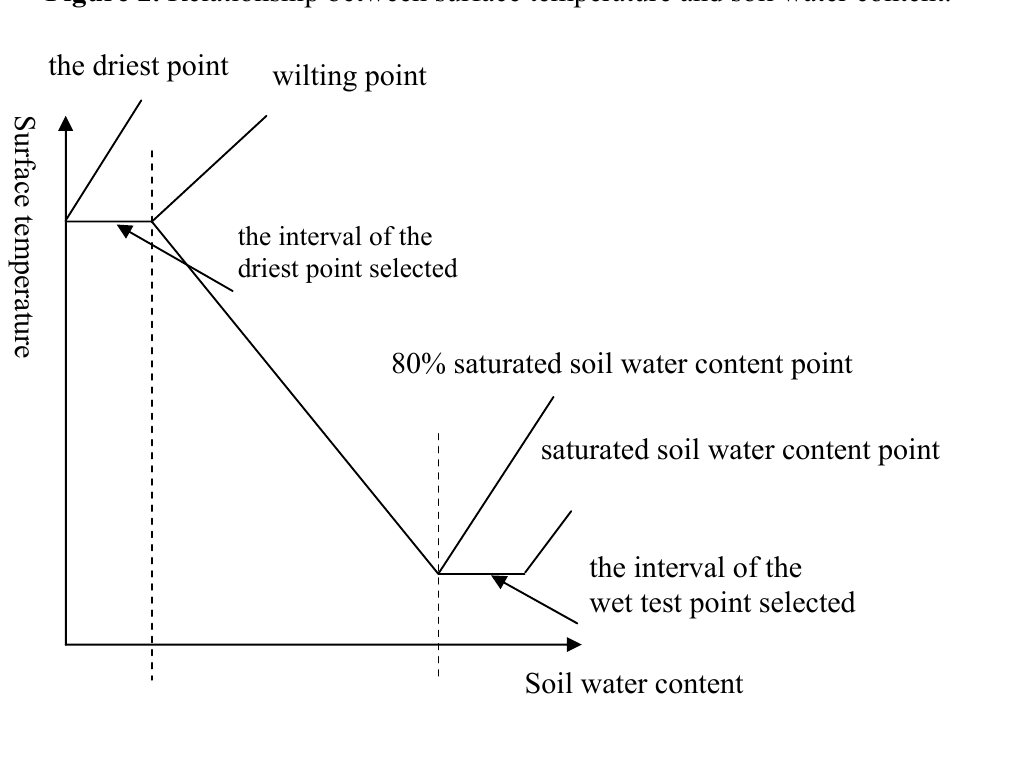
Figure 2. Relationship between surface temperature and soil water